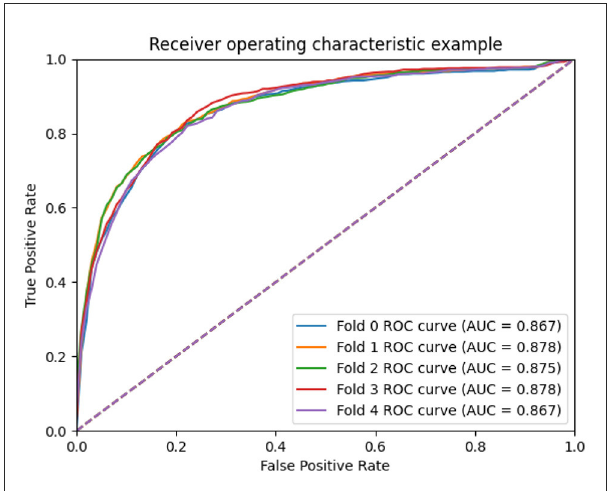
FIGURE4 AUC performance of GCNA-MDA model on 10-fold cross-validation.